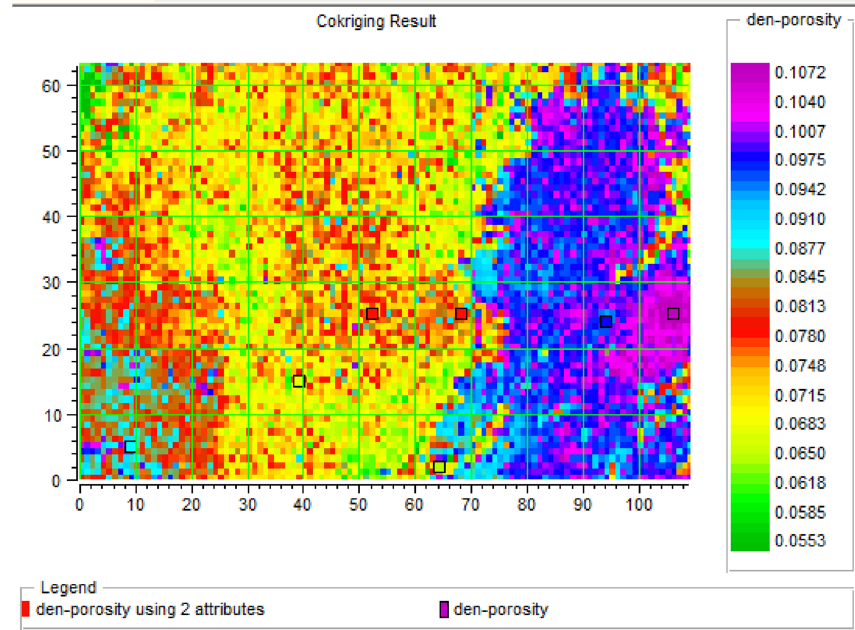
Fig. 40 2D porosity from geo- statistics_dataset2